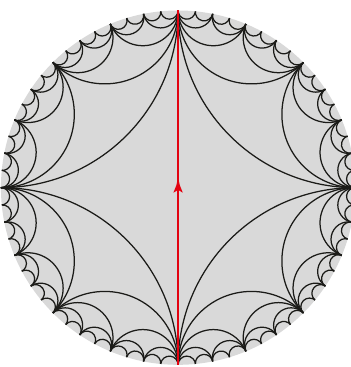
Figure 9 . The tessellation we obtain after (cid:13)ipping the distinguished oriented